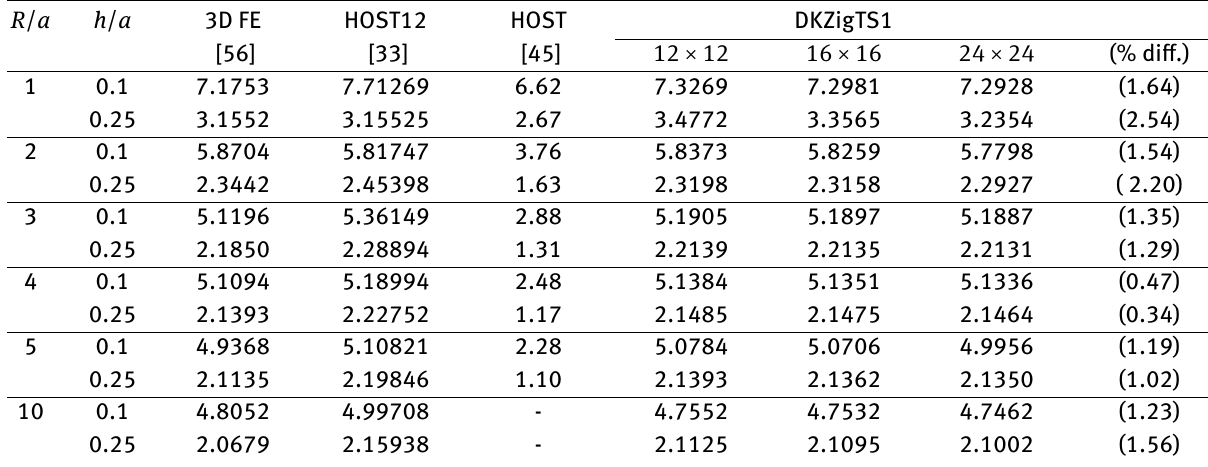
Table 5: Non-dimensionalised natural frequencies ¯ ω for an all-round simply supported sandwich cylindrical shell panel ‘D’ with b / a = 1